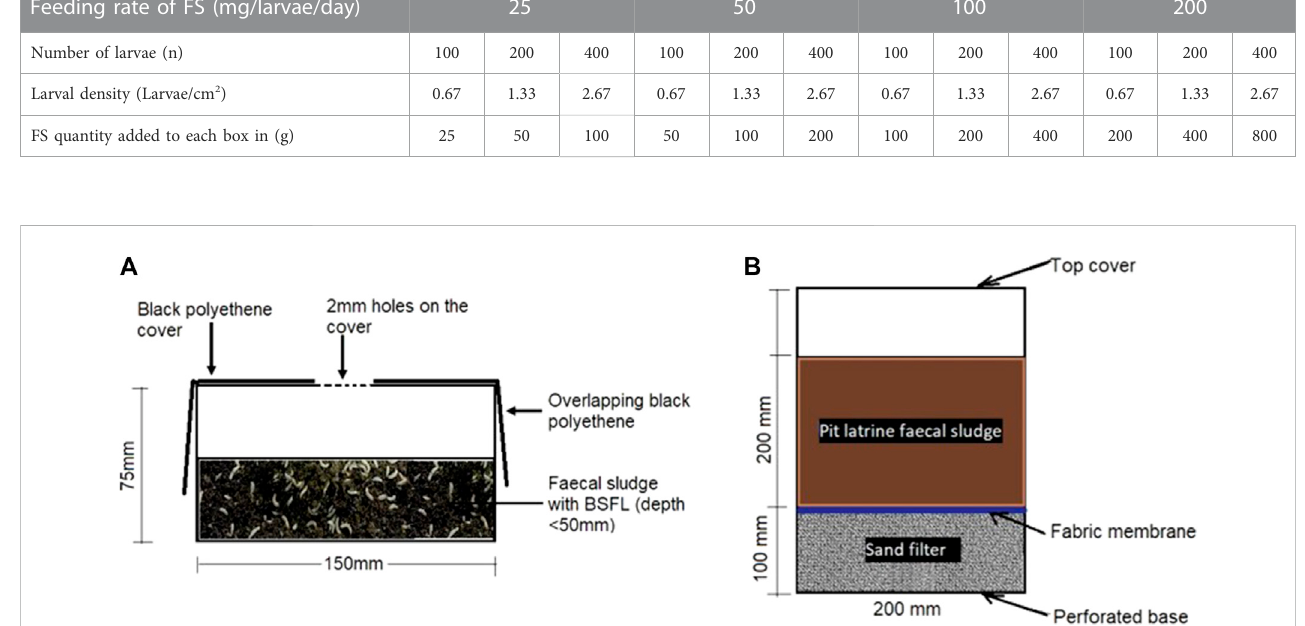
FIGURE 1 Experimental set up for: (A) feeding of black soldier fl y larvae on faecal sludge from pit latrines; and (B) Dewatering of pit latrine faecal sludge using a locally made sand fi